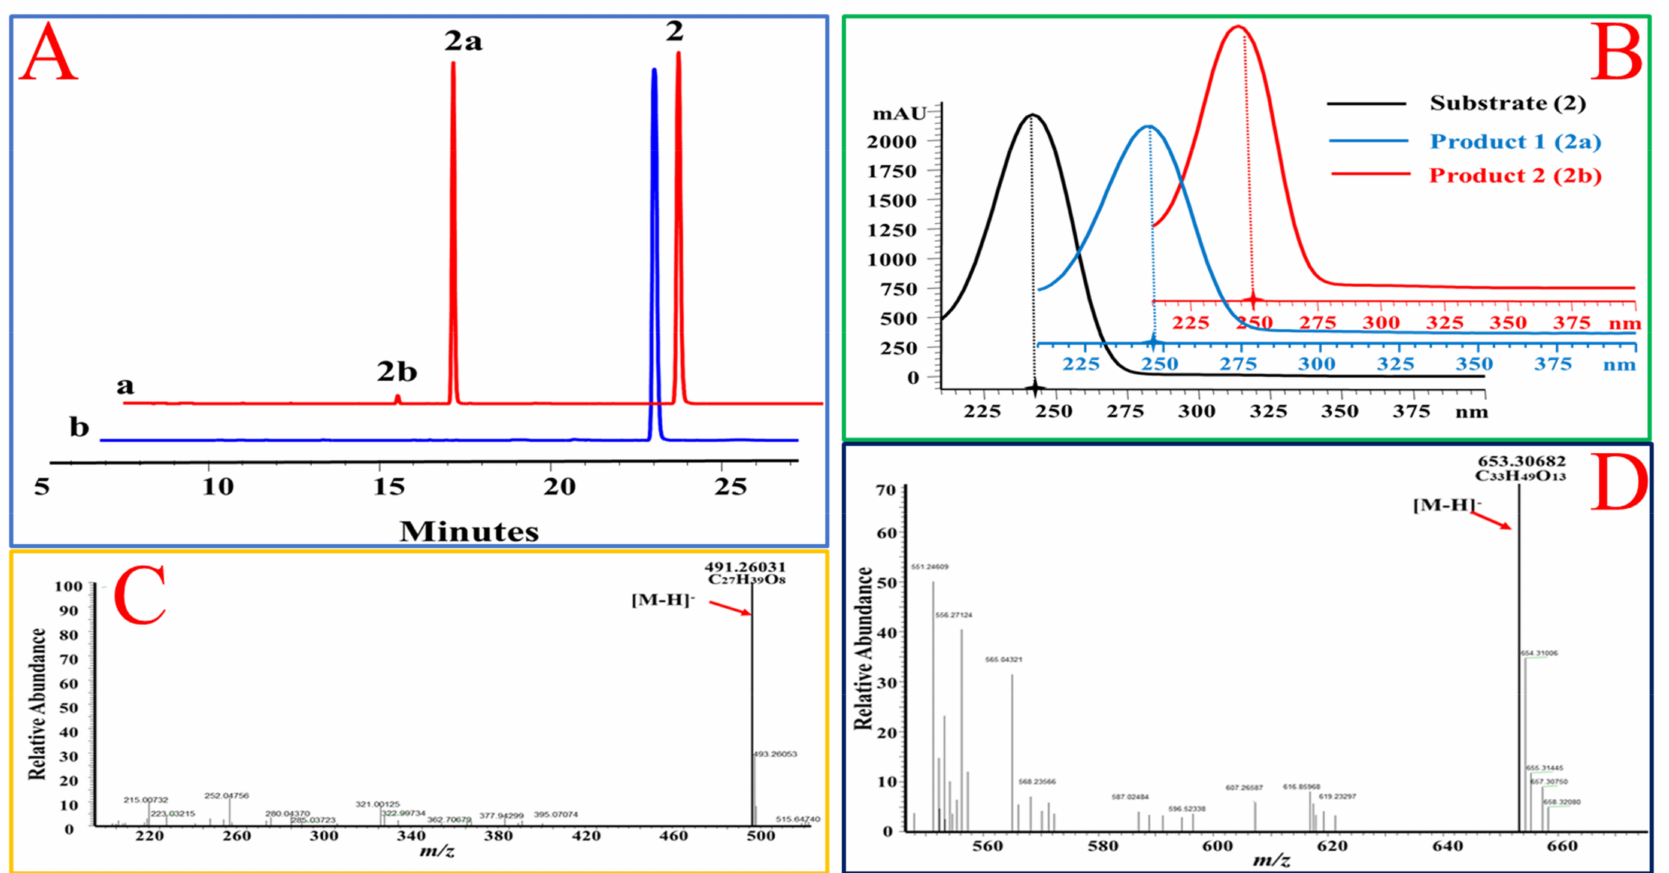
Figure 3. OcUGT1-catalyzed glucosylation of deoxycorticosterone ( 2 ). ( A ) HPLC profiles of deoxycorticosterone ( 2 ) glucosylation. ( a ) The reaction mixture of deoxycorticosterone ( 2 ) with the purified OcUGT1; ( b ) the reaction mixture of deoxycorticosterone ( 2 ) without the purified OcUGT1; 2 , 2a, and 2b refer to deoxycorticosterone ( 2 ) and its mono-glucoside and bioside, respectively. ( B ) UV spectra of deoxycorticosterone ( 2 ) and its glucosides. ( C ) HR-ESI-MS spectrum of deoxycorticosterone mono-glucoside ( 2a ). ( D ) HR-ESI-MS spectrum of deoxycorticosterone bioside ( 2b